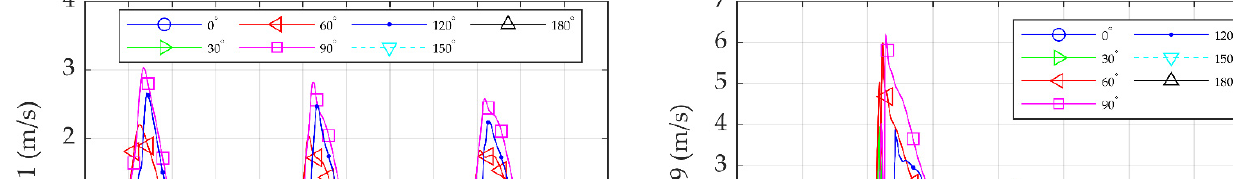
( b ) Figure 8. Velocity in the x -direction at different angles around the substructure over time for: ( a ) Gauge 1 and ( b ) Gauge 9. In Figure 9a,b, the velocity in the x -direction was correlated with different gauges. The gauges were placed at a 90-degree angle, where the velocity in the x -direction was highest, as shown in Figure 8, and the gauge heights differed in the z -direction. The details of the locations of the gauges are displayed in Figure 3 and Table 3, respectively. Gauges 1–4 were located in the water phase, whereas Gauges 5–7 were located near the free sur- face, and Gauges 8–14 were located near the wave breaking point above the mean water level. Figure 9a shows that Gauges 1–4 had small variations between them, with the max- imum velocity in the x -direction near 2.5 m/s during wave breaking. In Gauges 5–7, the maximum velocity in the x -direction was about 3.5 m/s near the mean water level. In Gauges 8–14, where the gauge height was near the wave breaking, the maximum velocity in the x -direction was about 6 m/s. ( a ) ( b ) Figure 9. Velocity in the x -direction for all the wave gauges at 90° over time for: ( a ) Gauges 1–7 and ( b ) Gauges 8–14.